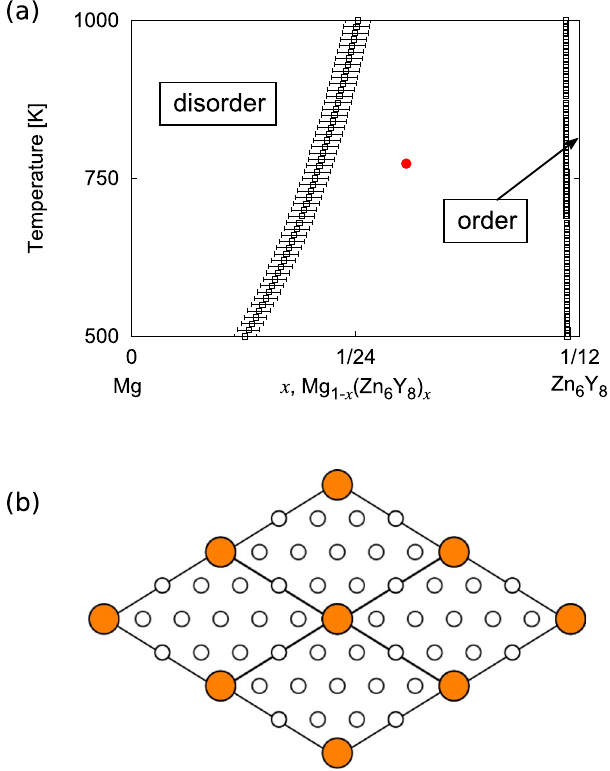
Figure 5. ( a ) Mg (Zn Y ) interface phase diagram. Black lines denote the phase-coexistent line between the x x 1 6 8 − ordered and disordered phases with error bars. Closed circle denotes a point where the STM image in Fig. 1(b) is obtained. ( b ) Ordered phase of the interface. Large and small circles denote Zn–Y clusters and Mg, respectively.